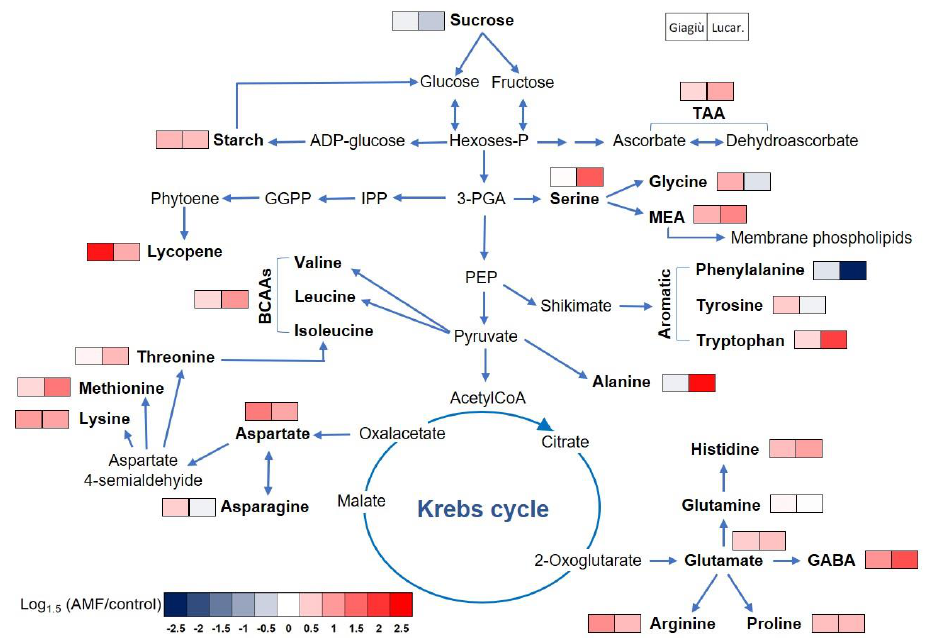
Figure 5. Pathway map summarizing the effect of arbuscular mycorrhizal fungi (AMF) on starch, sucrose, total ascorbic acid (TAA) and free amino acids, including branched-chain amino acids (BCAAs), and methyl ethanolamine (MEA) of yellow-pigmented type (‘Giagiù’) and red-pigmented type (Lucar.) landraces of Pomodorino del Piennolo del Vesuvio (PPV) cultivated in Campania region under rainfed conditions. The heat map results were calculated as Logarithm base 1.5 (Log1.5) of AMF/Control values and visualized using a false-color scale, with red indicating an increase and blue a decrease of values.